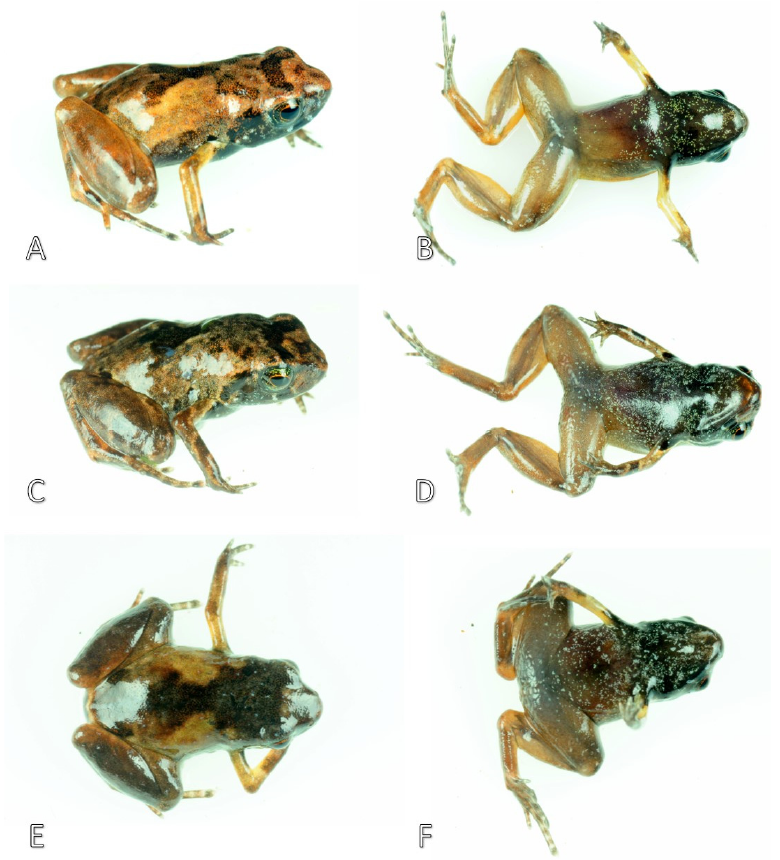
Figure 8. Photographs of live specimens of Noblella losamigos sp. n. ( A ) Dorsal view and ( B ) ventral view of MUBI 17413, adult male paratype (SVL 9.6 mm); ( C ) dorsal view and ( D ) ventral view of CORBIDI 17520, adult male paratype (SVL 11.1 mm); ( E ) dorsal view and ( F ) ventral view of CORBIDI 17521, adult male paratype (SVL 9.6 mm). Photographs by A.